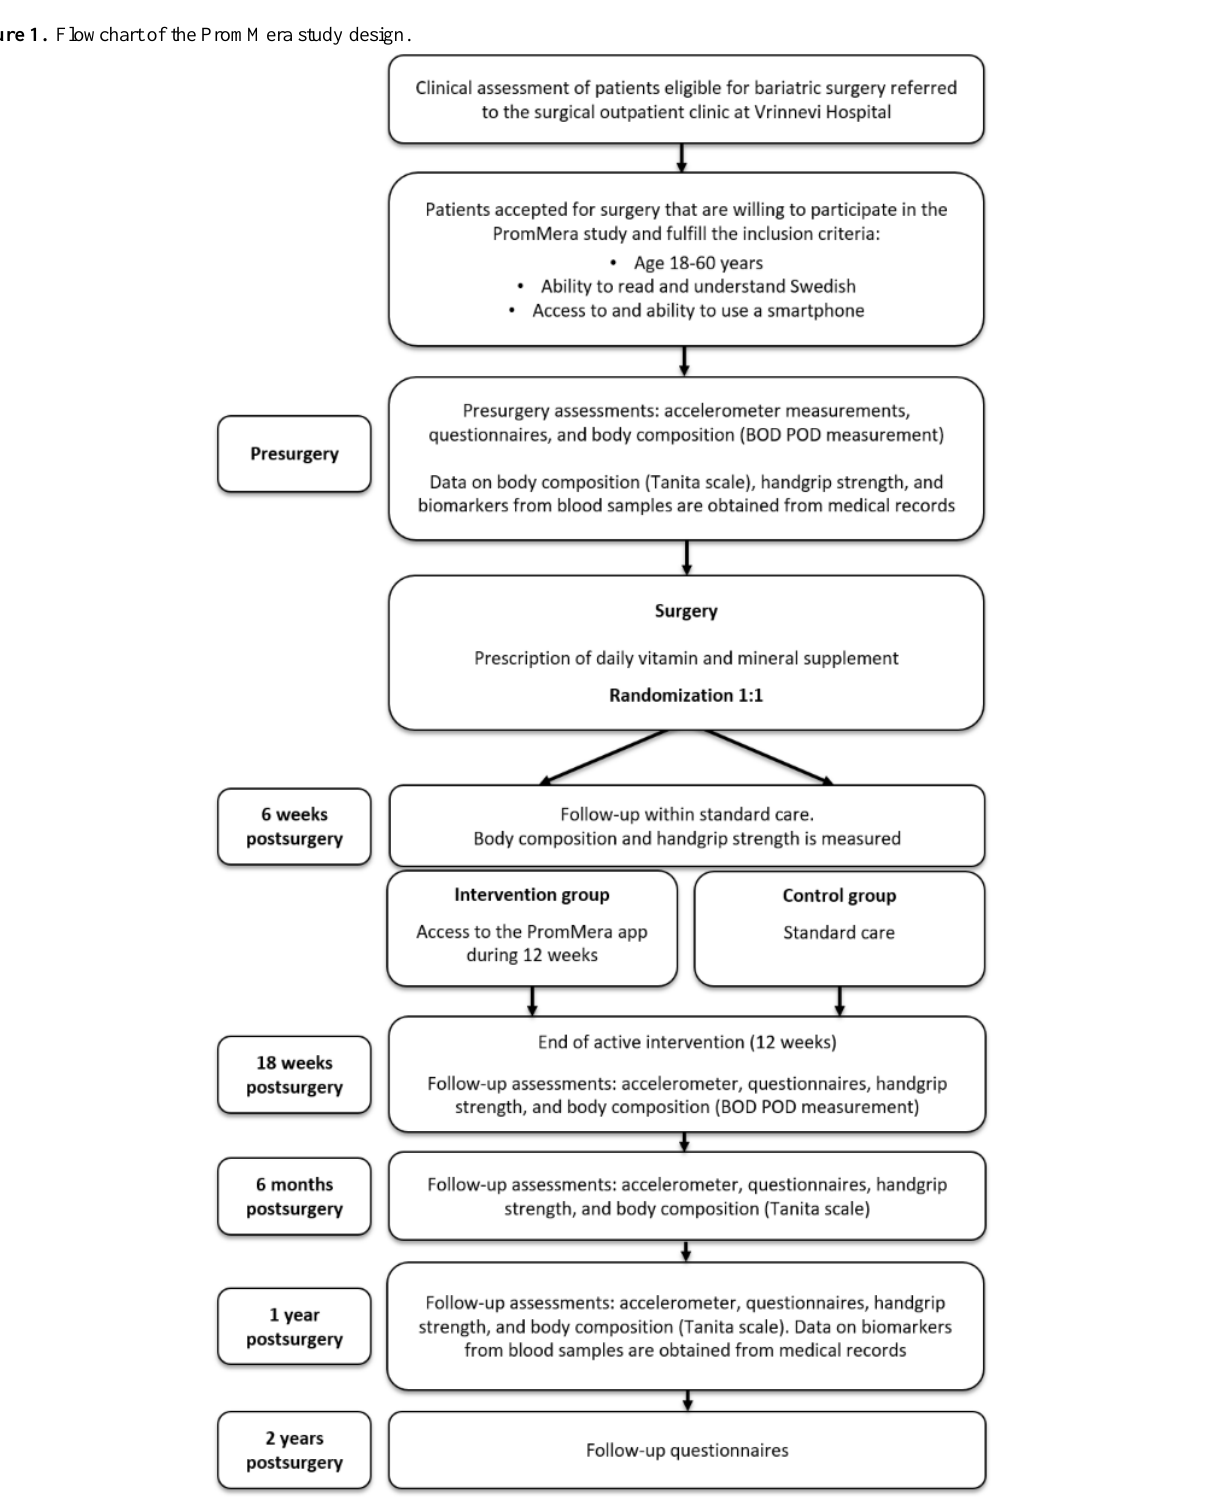
Figure 1. Flowchart of the PromMera study